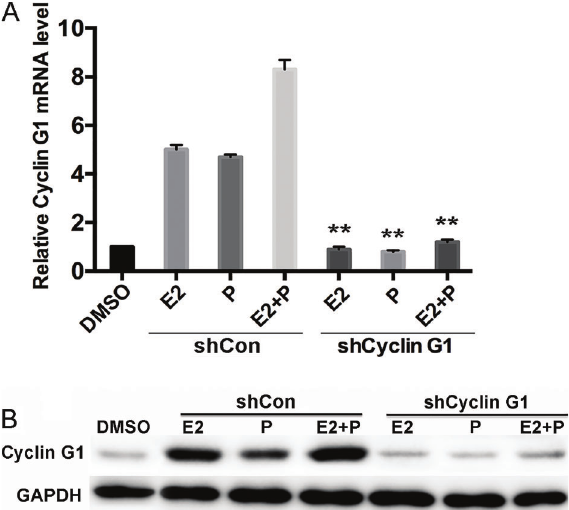
Figure 5. Synthesized shRNA against cyclin G1 (shCyclin G1) successfully depleted the expression of cyclin G1 in MCF-7 cells. A , Cyclin G1 mRNA expression was detected by q-PCR in the cells treated with estradiol (E2) and progesterone (P). B , The protein level of cyclin G1 was detected by western blot. Data are reported as means ± SD. **P o 0.01 vs shCon (scrambled shRNA as control) (Student ’ s t